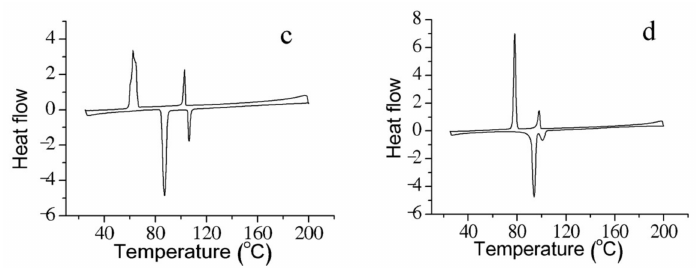
Figure 3. DSC traces of ( a ) compound 2a; ( b ) compound 2b; ( c ) compound 2c; and ( d ) compound 2d.